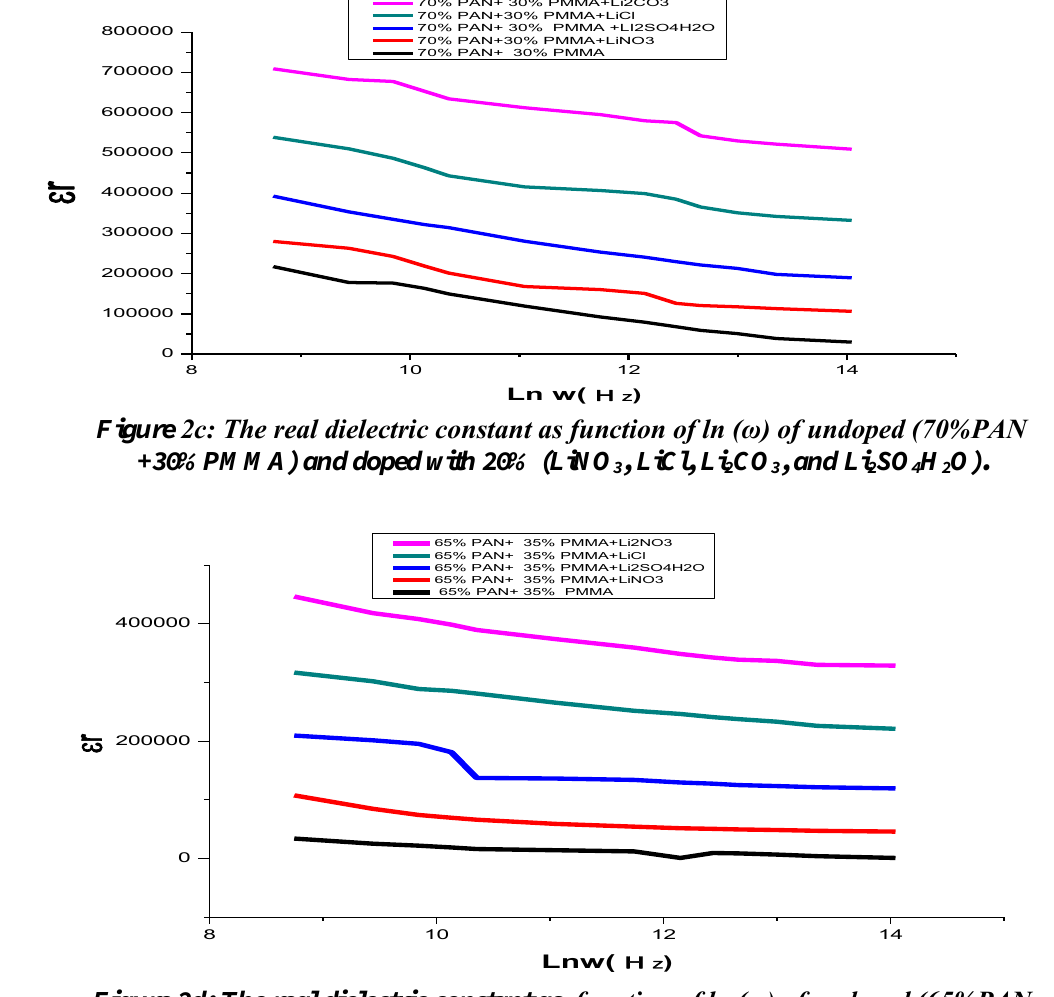
, LiCl, Li CO , and Li SO H O). 3 2 3 2 4 2